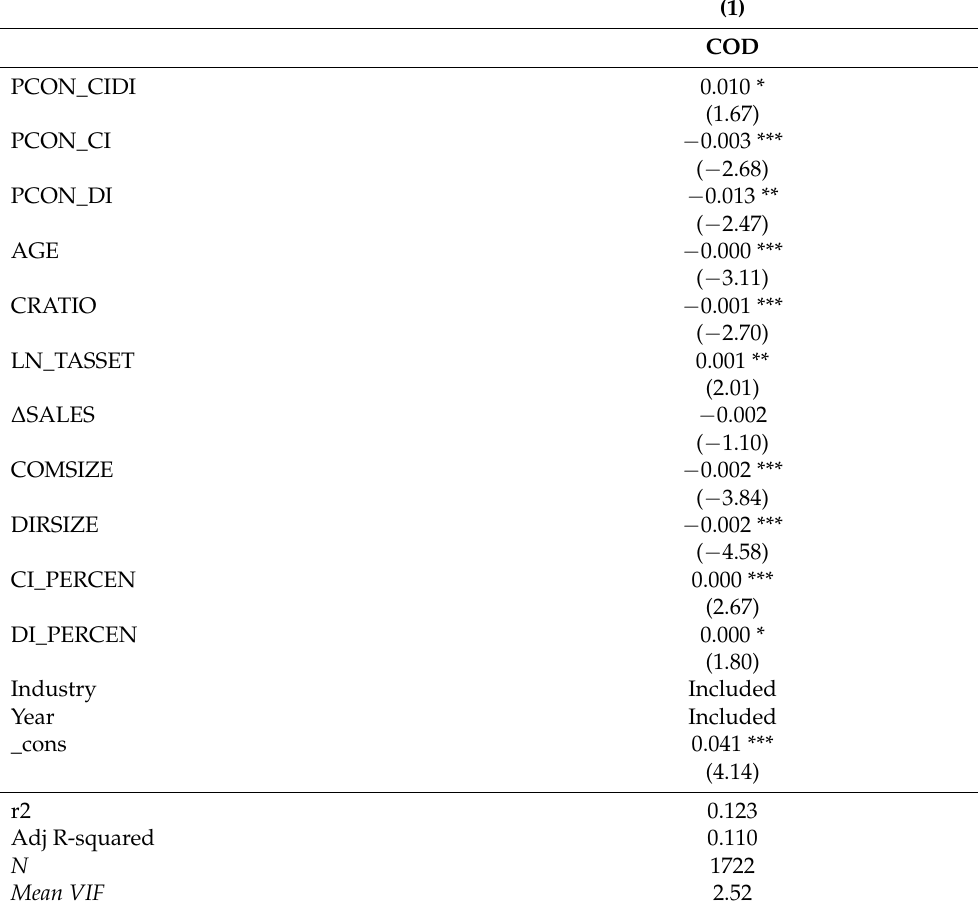
Table 14. Regression of PCON_CIDI, PCON_CI, and PCON_DI on the cost of debt